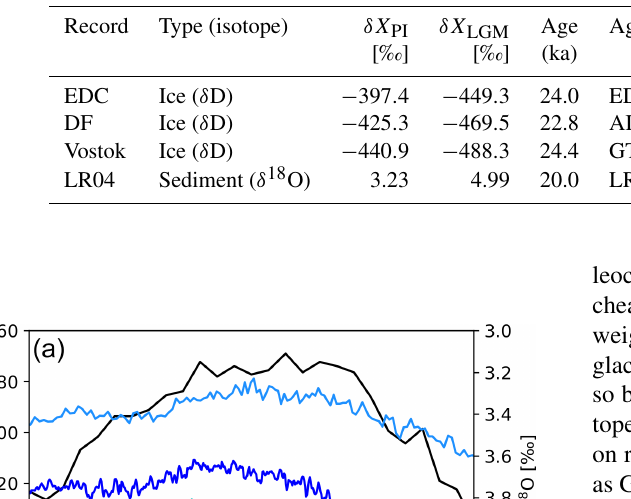
Table 2. Ice and sediment cores reference values used in Eq. (3), together with the age (in thousand years before present; ka) from which the Last Glacial Maximum (LGM) reference values were obtained. The respective age models of each core, and their references, are listed.